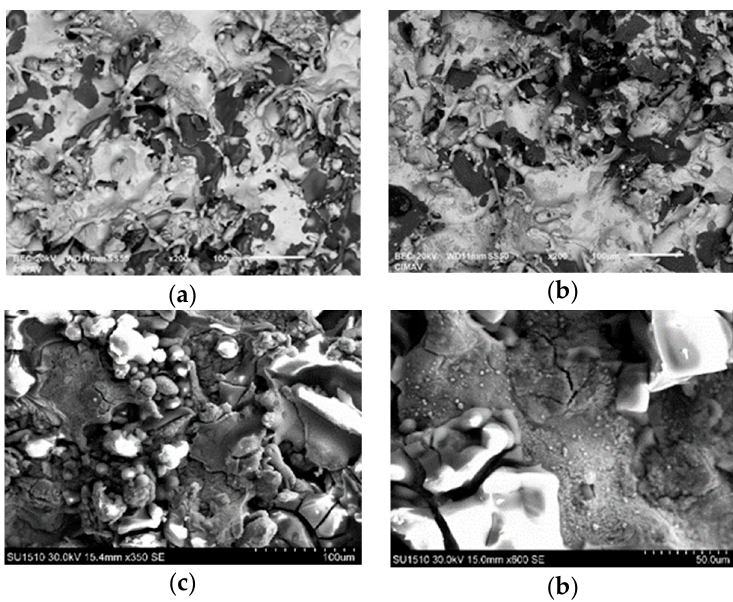
Figure 15. ( a ) and ( b ) SEM micrograph of the surface of the coating with 359 kPa oxygen–69 kPa acetylene applied before the EIS test. ( c ) and ( d ) Micrography of the surface of the coating with 359 kPa oxygen–69 kPa acetylene applied after the EIS test at 350× and 600×.